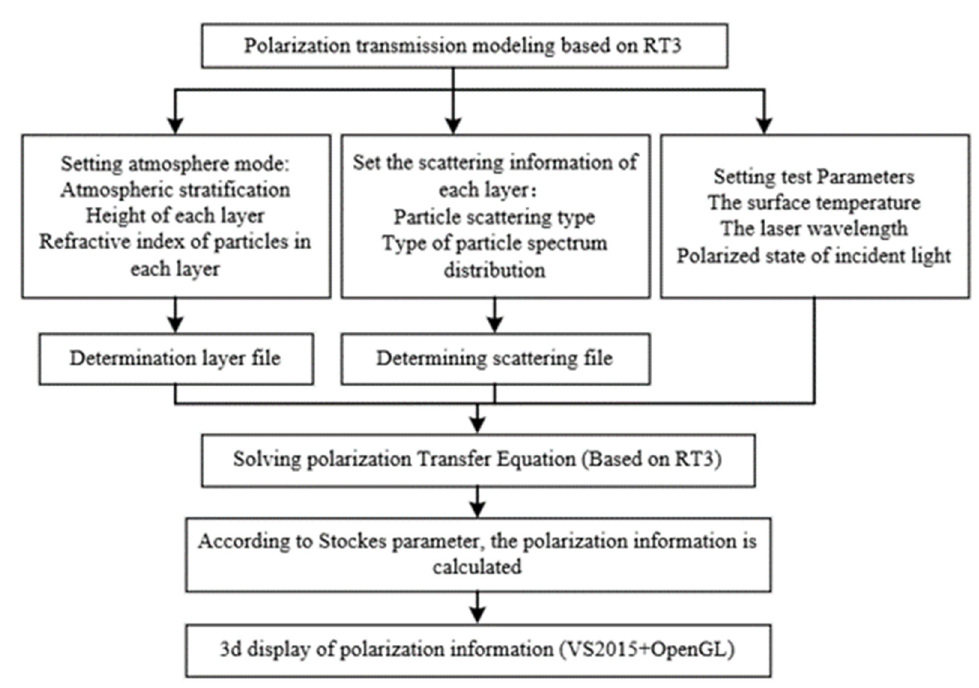
Figure 1. Flowchart of the modeling of sea fog polarization based on RT3.